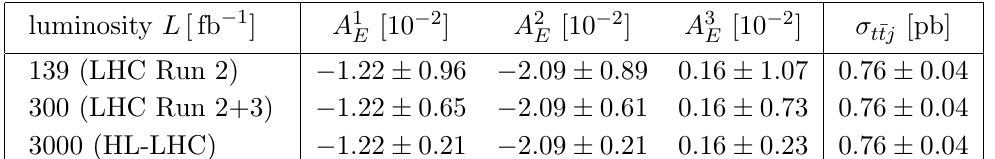
Table 2 . Particle-level predictions for the energy asymmetry A opt cross section (cid:27) in the (cid:12)ducial region at the LHC with t (cid:22) tj expected experimental uncertainties in a measurement using data sets of integrated luminosity L